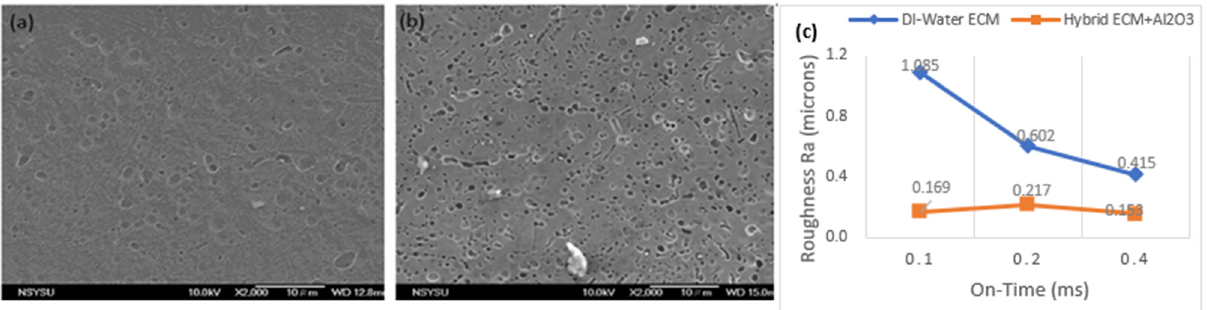
Figure 11. Comparison of the surface with ( a ) DI-water ECM, ( b ) hybrid alumina abrasive ECM polishing (×2000). ( c ) Surface roughness of ECM polishing schemes vs. pulse on-time T ON.